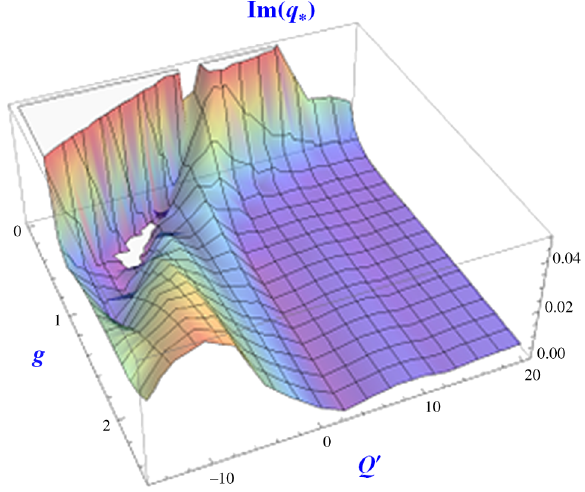
FIG. 8. Highest growth rate versus gain and chromaticity.